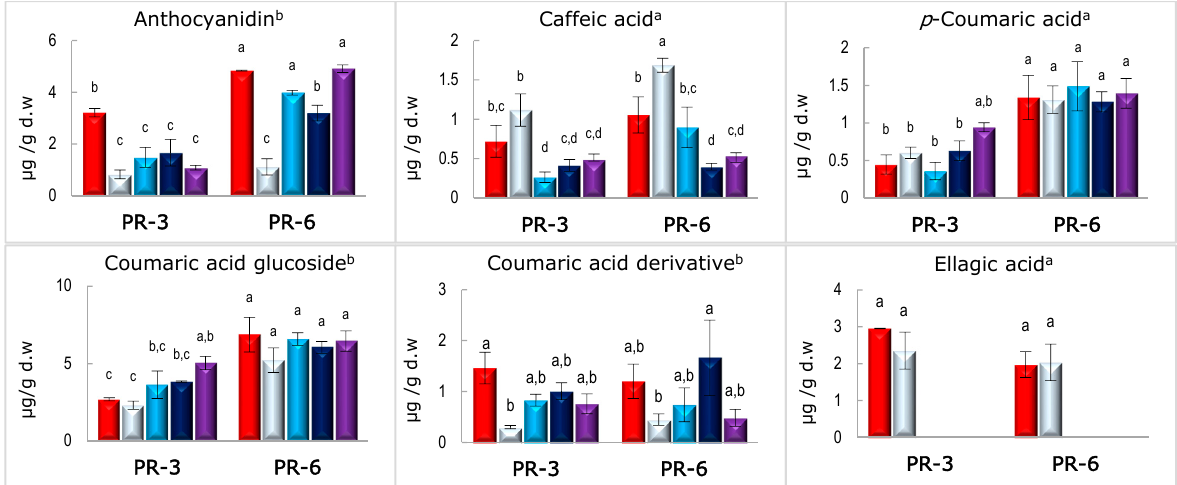
Figure 3. Chromatograms of bound polyphenols in the undigested pork liver pâté samples. CP: control pâté; PR-3 pâté with 3% persimmon flour (Rojo Brillante); PR-6 pâté with 6% persimmon flour (Rojo Brillante); mAU: milli-absorbance unit.